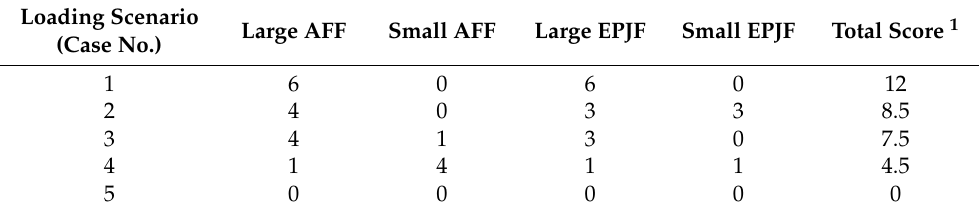
Table 5. Annulus and endplate junction failures obtained in the in vitro